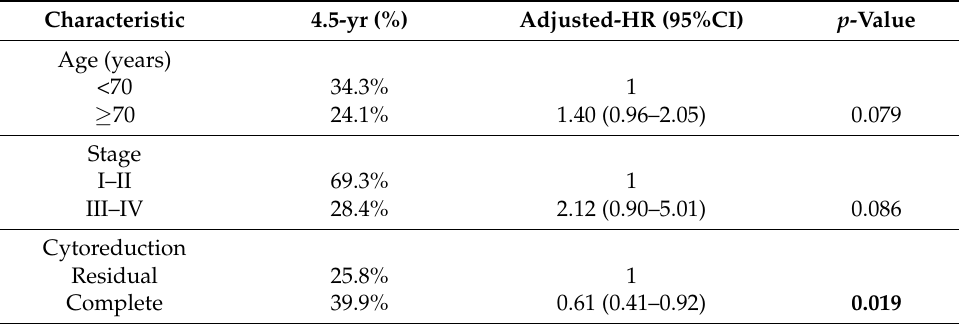
Table 5. Independent factors for overall survival ( n = 181, whole